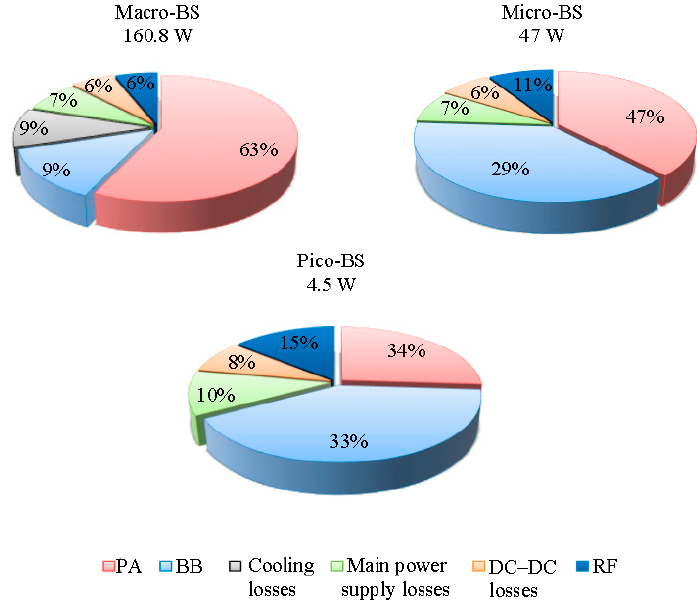
Figure 4. Power consumption of the components of BSs per antenna and sector [23,24].